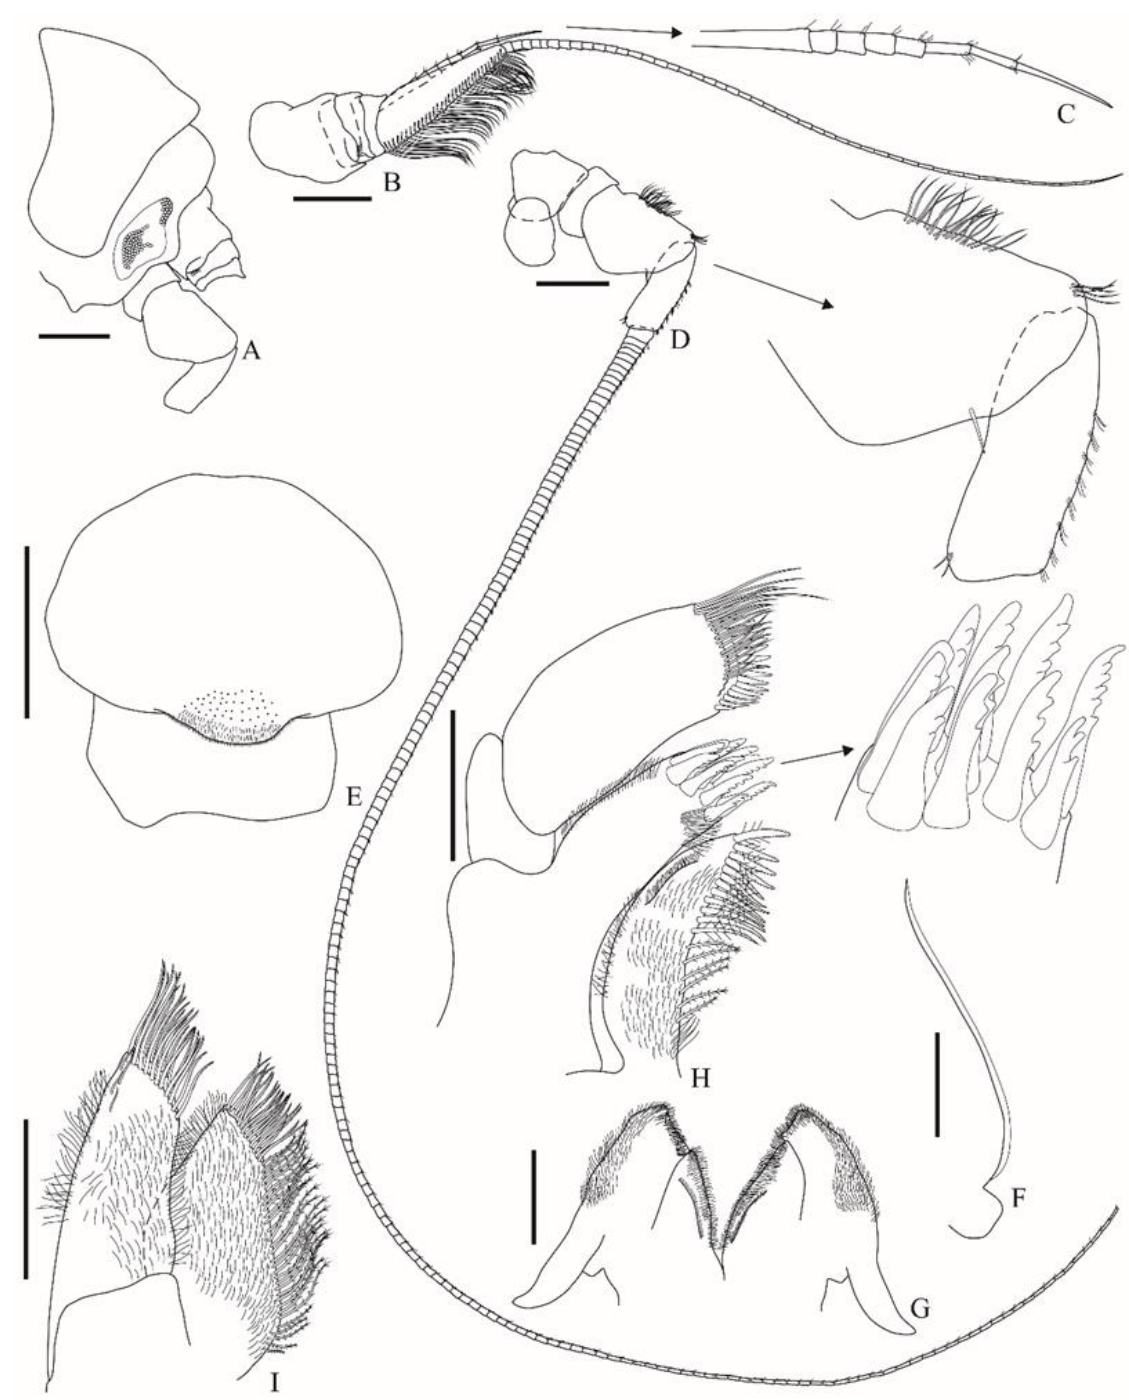
Figure 2. Cyphocaris boecki sp. nov., female holotype, 33.3 mm (MOUFPE 20068). ( A ) Head; ( B ) antenna 1; ( C ) accessory flagellum of antenna 1; ( D ) antenna 2; ( E ) upper lip; ( F ) epistome; ( G ) lower lip; ( H ) maxilla 1; ( I ) maxilla 2. Scale bars: 1 mm for ( A , B , D ); 0.5 mm for ( E – I ).